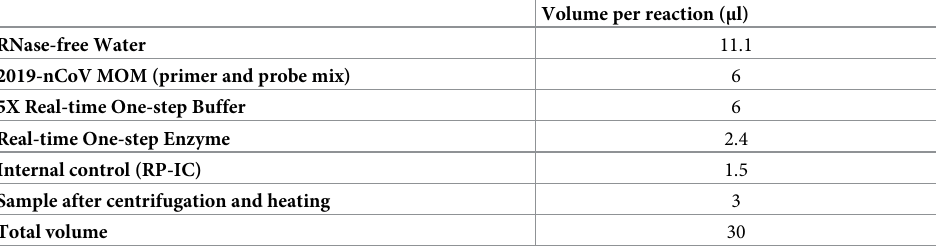
Table 1. RT-PCR reaction